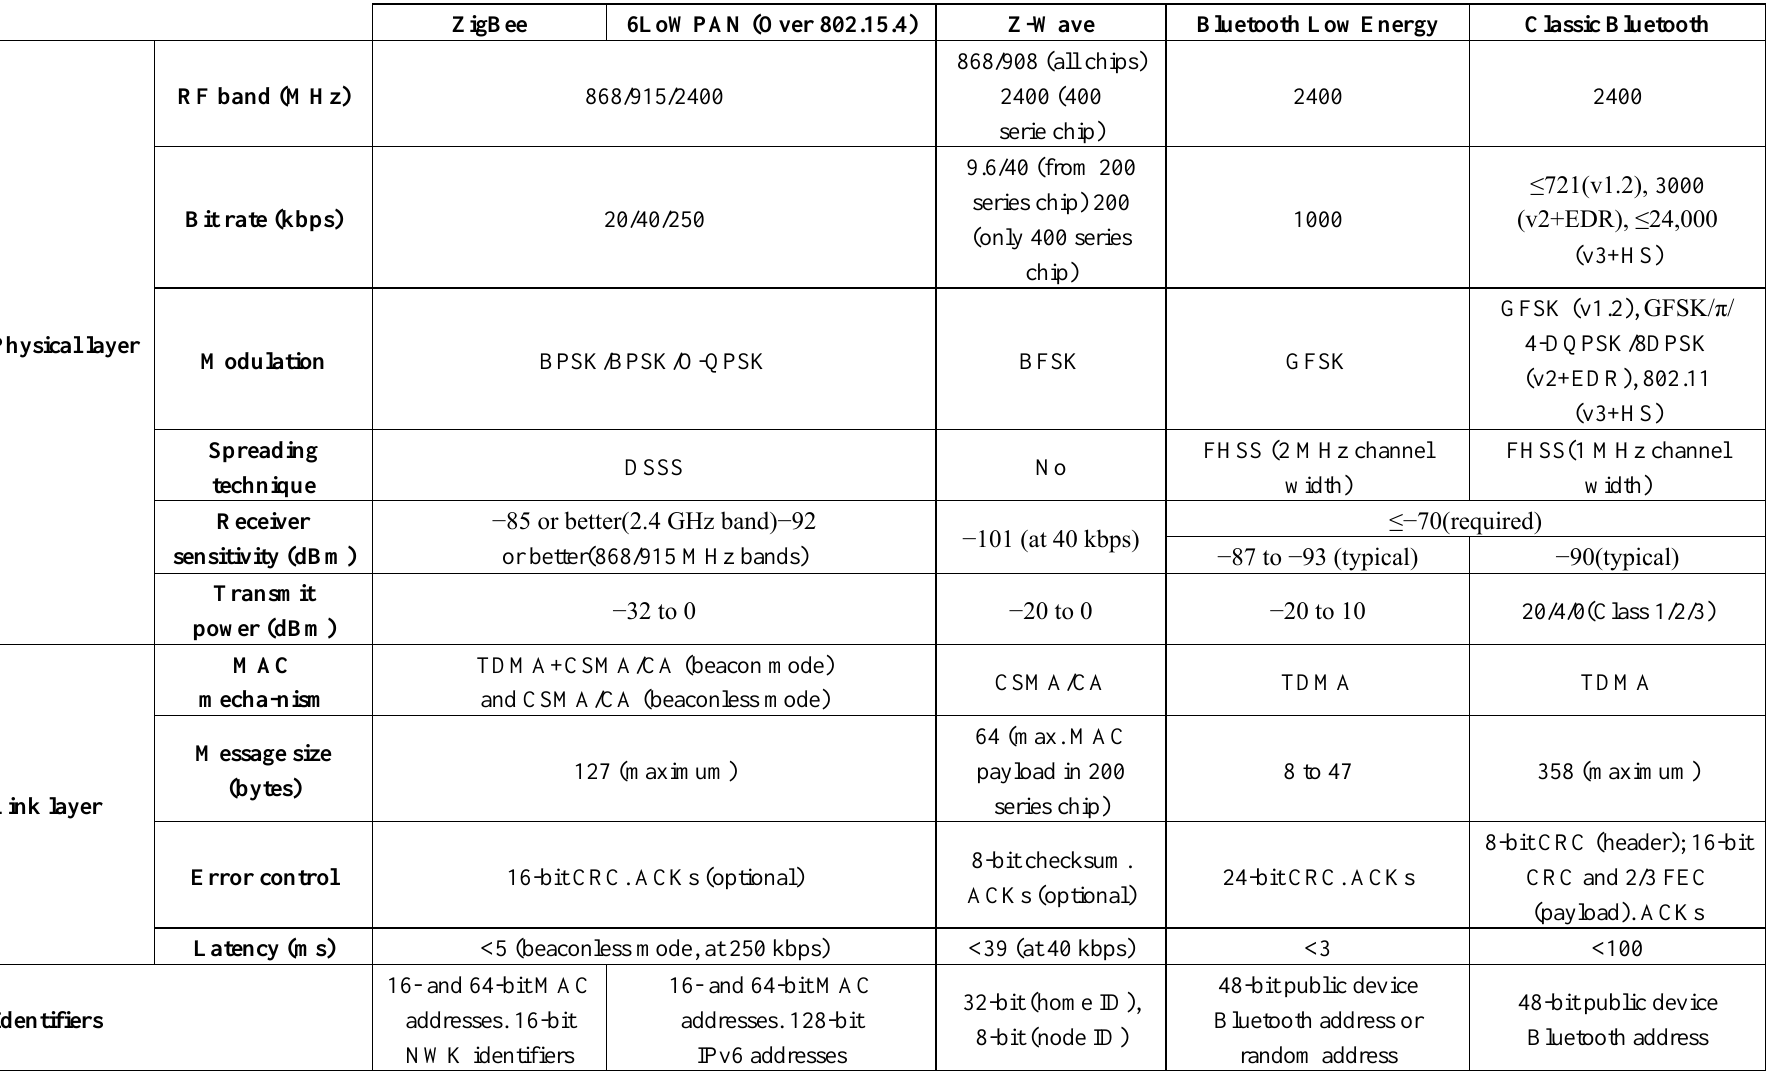
Table 2. Main characteristics of ZigBee, 6LoWPAN, Z-Wave, BLE and classic Bluetooth. The data of ZigBee, 6LoWPAN and Z-Wave has been obtained or adapted from the literature